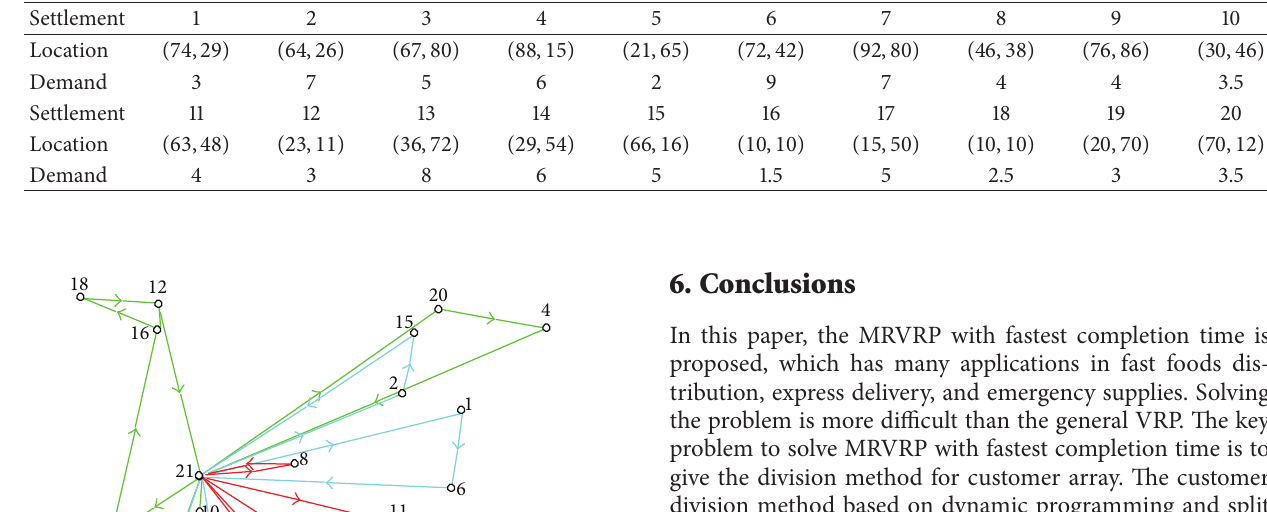
Table 1: Locations and demands of settlement.